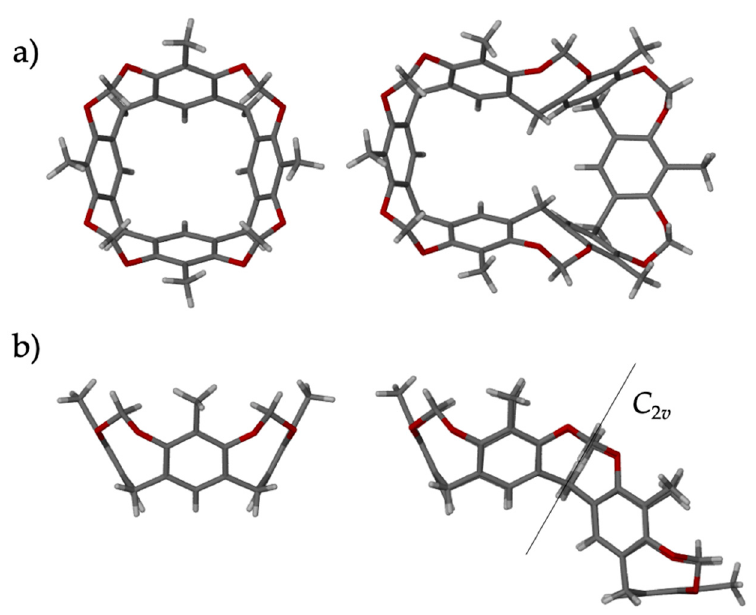
Figure 6. Comparison of the crystal structures of MeHCH 2 (left; CSD code VUWMIL [56]) and MeHCH 2 -6 (right; CSD code QUCWOA [55], chloroform solvate, solvent molecules omitted for clarity), illustrating the similarities of a portion of their molecular structures. ( a ) top view, ( b ) side view.